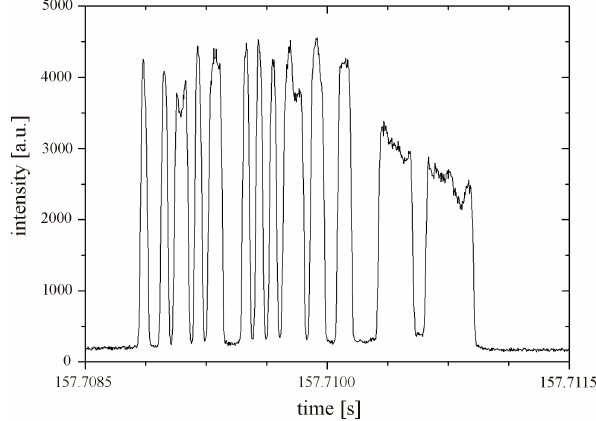
Figure 2. Sketch [10] of the spatially modulated mask showing the 50-digit binary sequence. The width of each digit is 20 µm. The total mask length is 980 µm starting left of the open feature (#1) and ending right of the last open feature (#49). The last feature (#50) is opaque and therefore not distinguishable from the mask body.